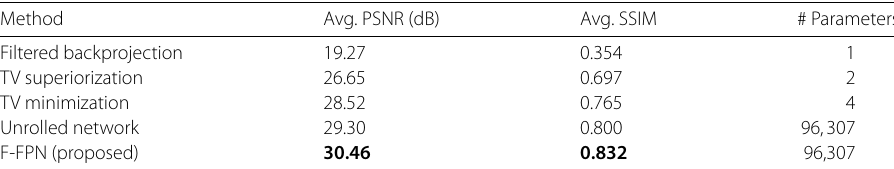
Table 2 Average PSNR/SSIM on the 2000 image LoDoPab testing